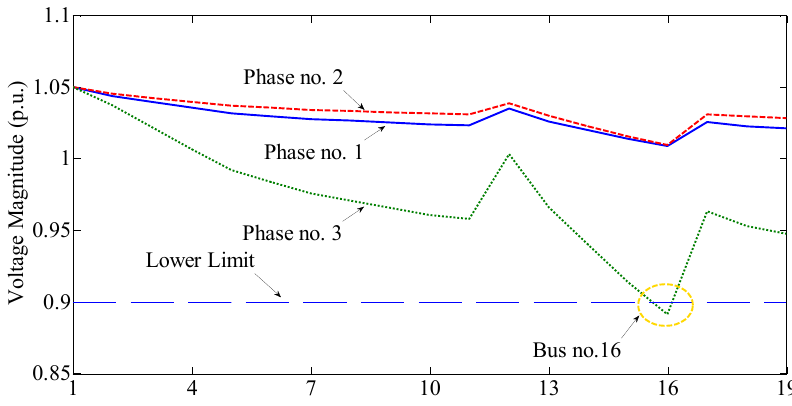
Figure 6. Case Study 1: Voltage magnitude of the residential feeder at hour 21.00 of the typical day.